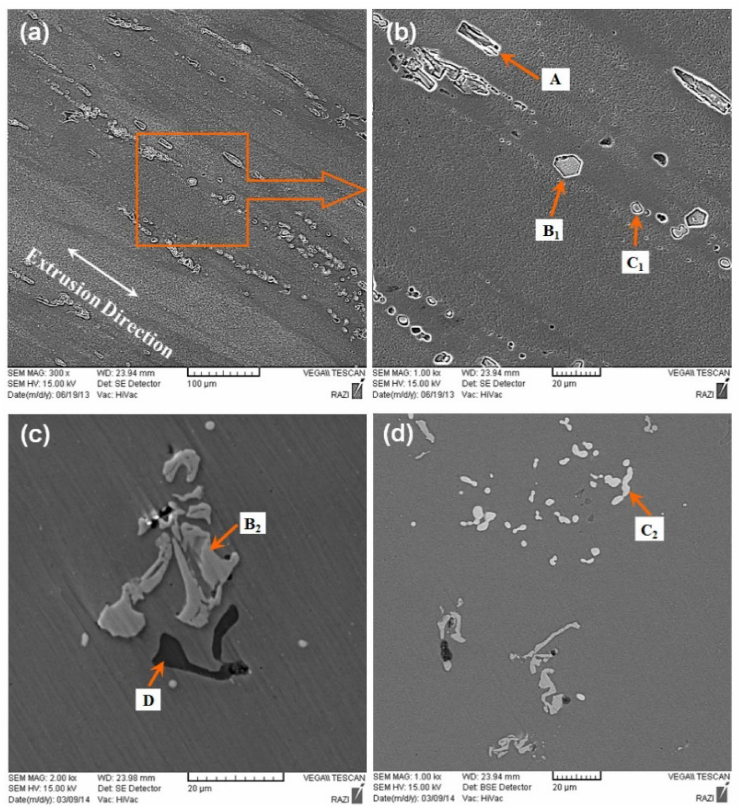
Figure 1. ( a ) Scanning electron microscope (SEM) secondary electron image; ( b ) SEM secondary electron image of selected area in (a); ( c ) SEM secondary electron image; ( d ) SEM backscattered electron image of as-received 7075